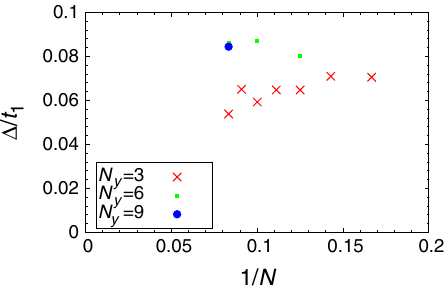
FIG. 3. Energy gap (cid:2) for different system sizes and aspect ratio. The gap is defined as the difference between the energy of the first excited state and the highest energy of the 3-fold ground- state manifold. In each case, N x ¼ 3 N=N y .